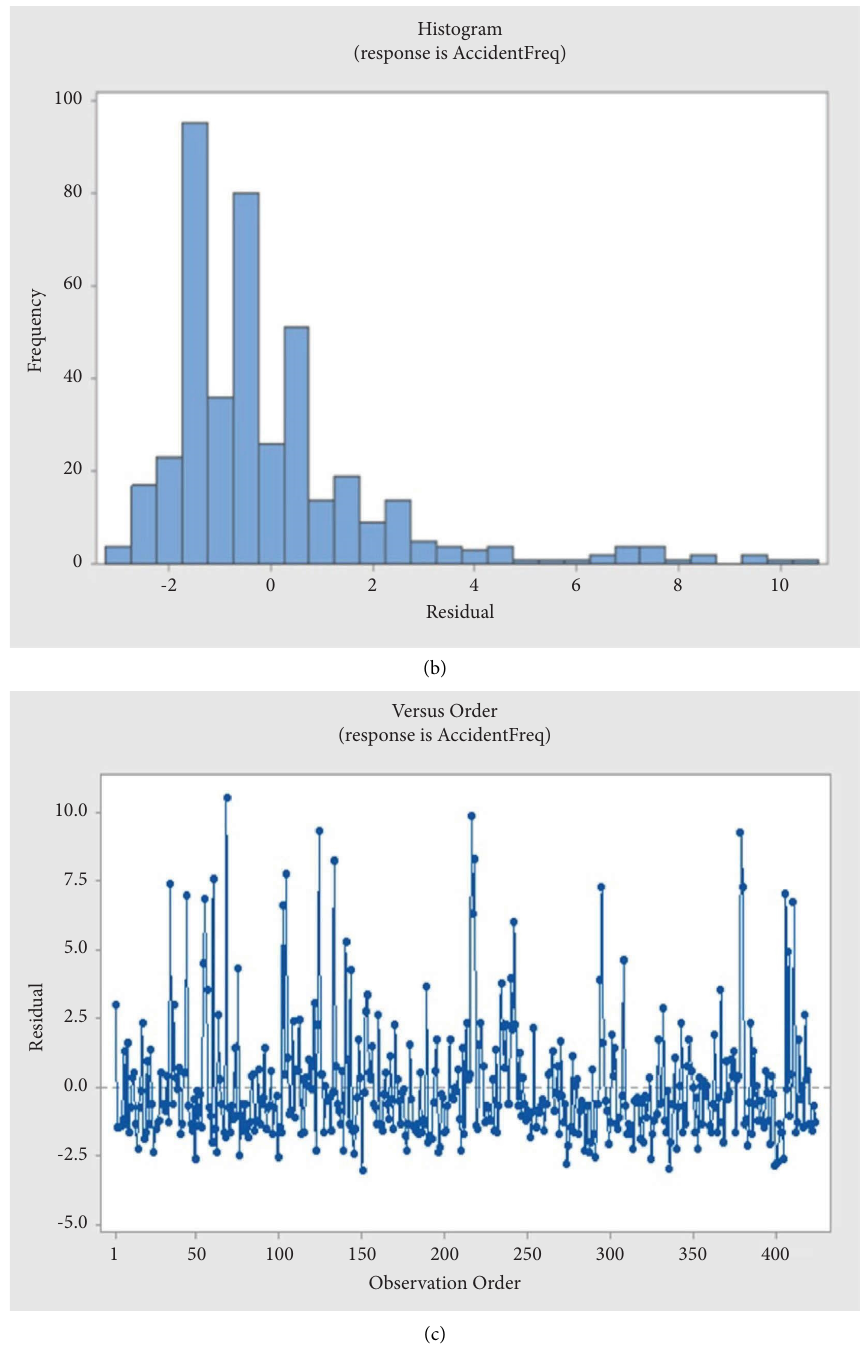
Figure 2: (a) Normal probability plot, (b) histogram of frequency versus residual for accident frequency, and (c) versus order